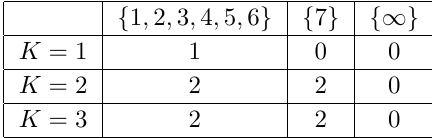
Table 4 . Number of Bethe roots for decomposed BAE with M = 7.